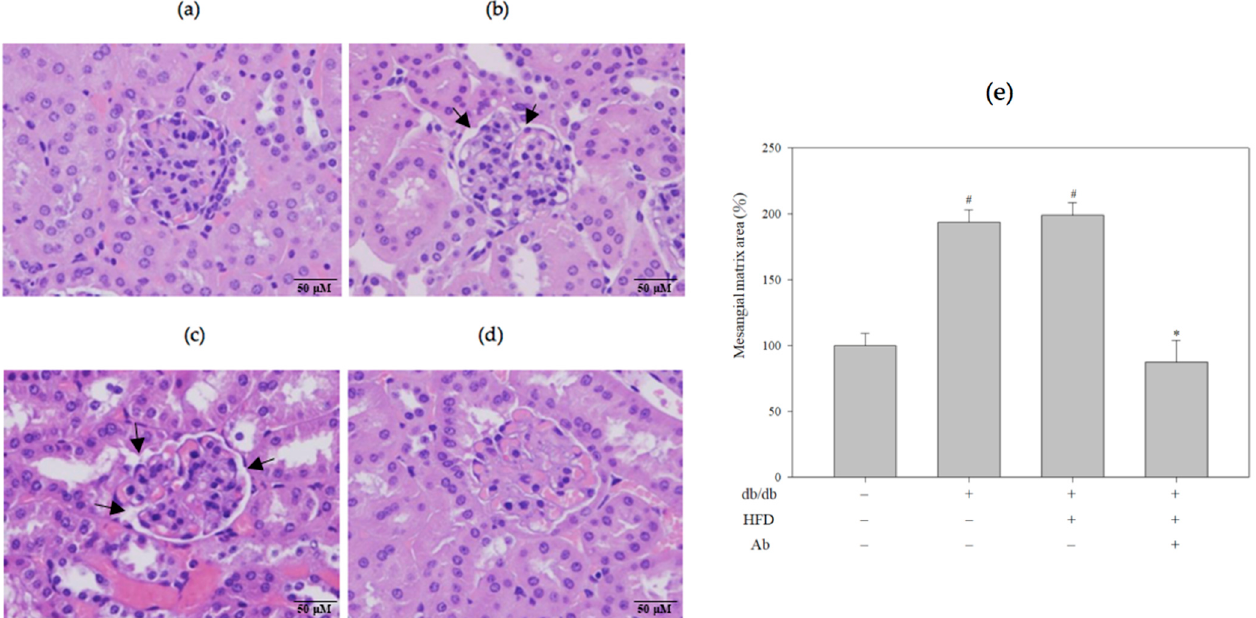
Figure 2. Ab decreased glomerular hypertrophy and expansion of the mesangial matrix in the glomeruli. Kidney slices were embedded in paraffin and stained with hematoxylin and eosin (H&E). Light photomicrographs of kidney sections from ( a ) control group (C57BL/6 mice), ( b ) db/db group, ( c ) db/db+HFD group, ( d ) db/db+HFD+Ab group were displayed (400× magnification). Arrow indicates the location of mesangial matrix expansion in the glomeruli. ( e ) Quantification of the mesangial matrix area. Fifteen microscopic fields of glomeruli per mice were randomly examined. Data are presented as mean ± SD; n = 3 mice per group. The results were analyzed using the analysis of Student’s t -test. #, p < 0.05 compared with the control group. *, p < 0.05 compared with the db/db+HFD